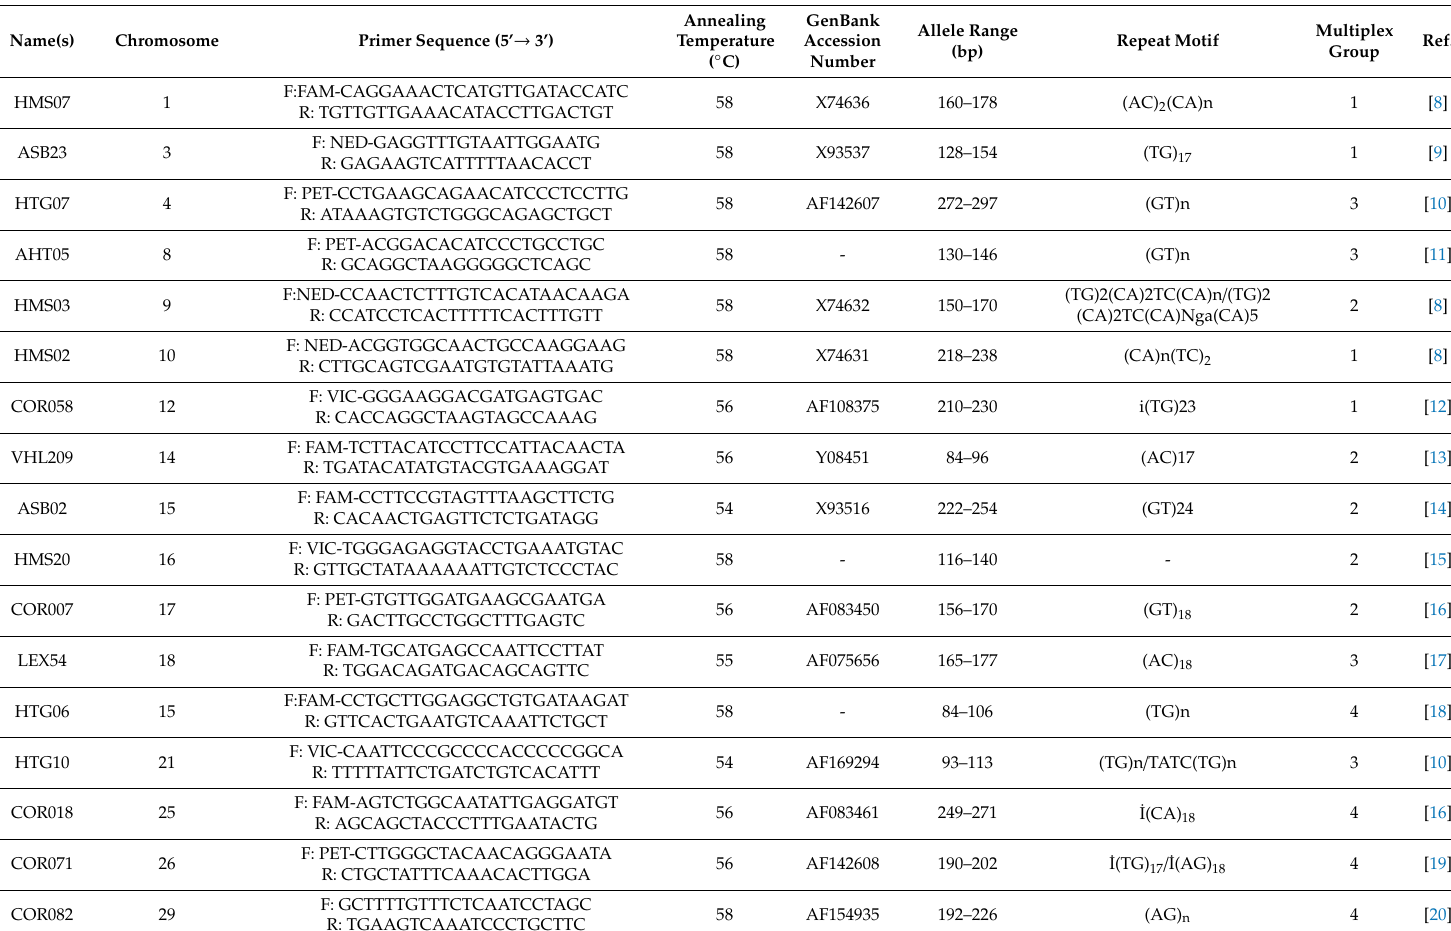
Table 2. Genomic characteristics of the 17 microsatellite loci *; chromosome numbers, primer sequences with the fluorescent labels, annealing temperatures, GenBank accession numbers, allele size ranges, repeat motifs and the